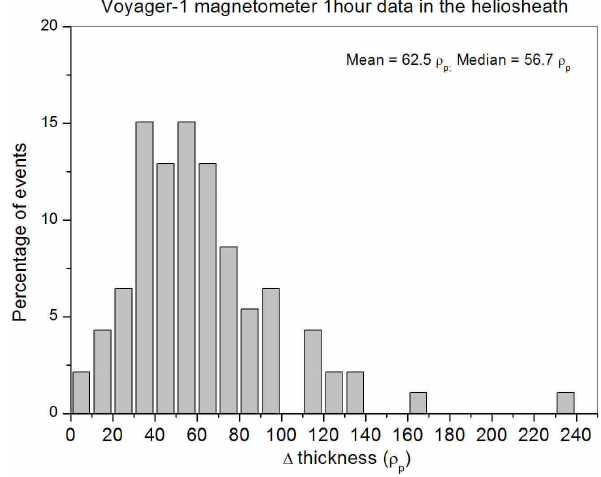
Fig. 15. The spacings between adjacent magnetic dips in the he-